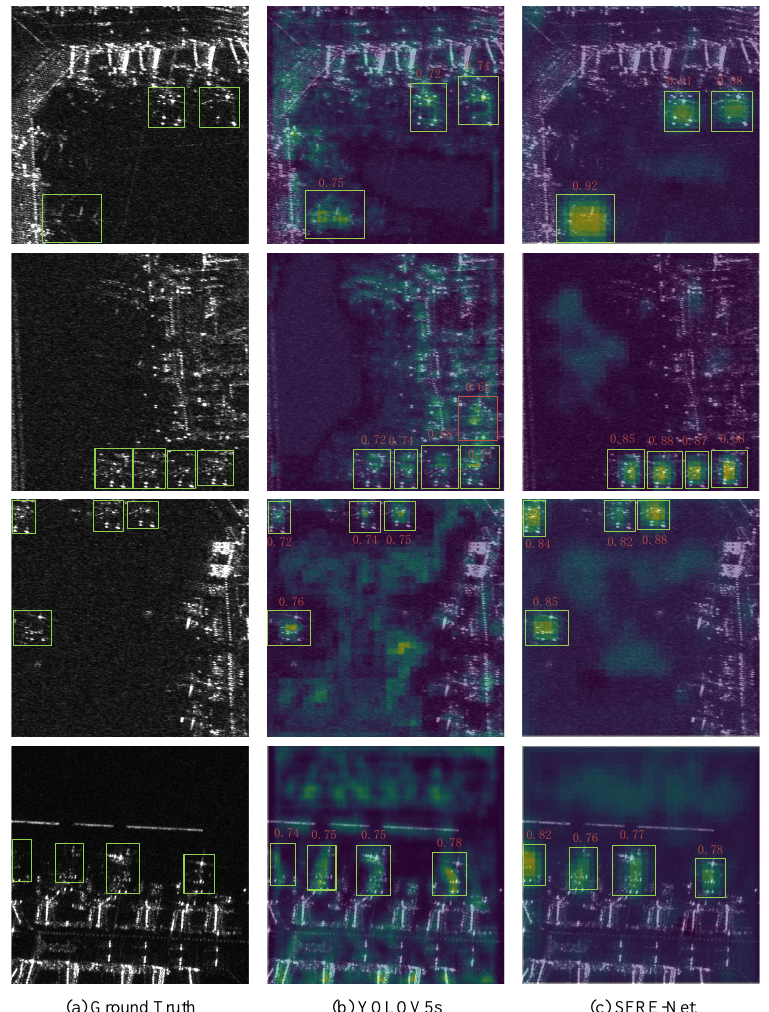
Figure 12. Detection confidence visualization. ( a ) Ground Truth of SAD. ( b ) Detection confidence map for the baseline. ( c ) Detection confidence map for SFRE-Net. The green boxes and red boxes indicate the correct detections and false alarms,